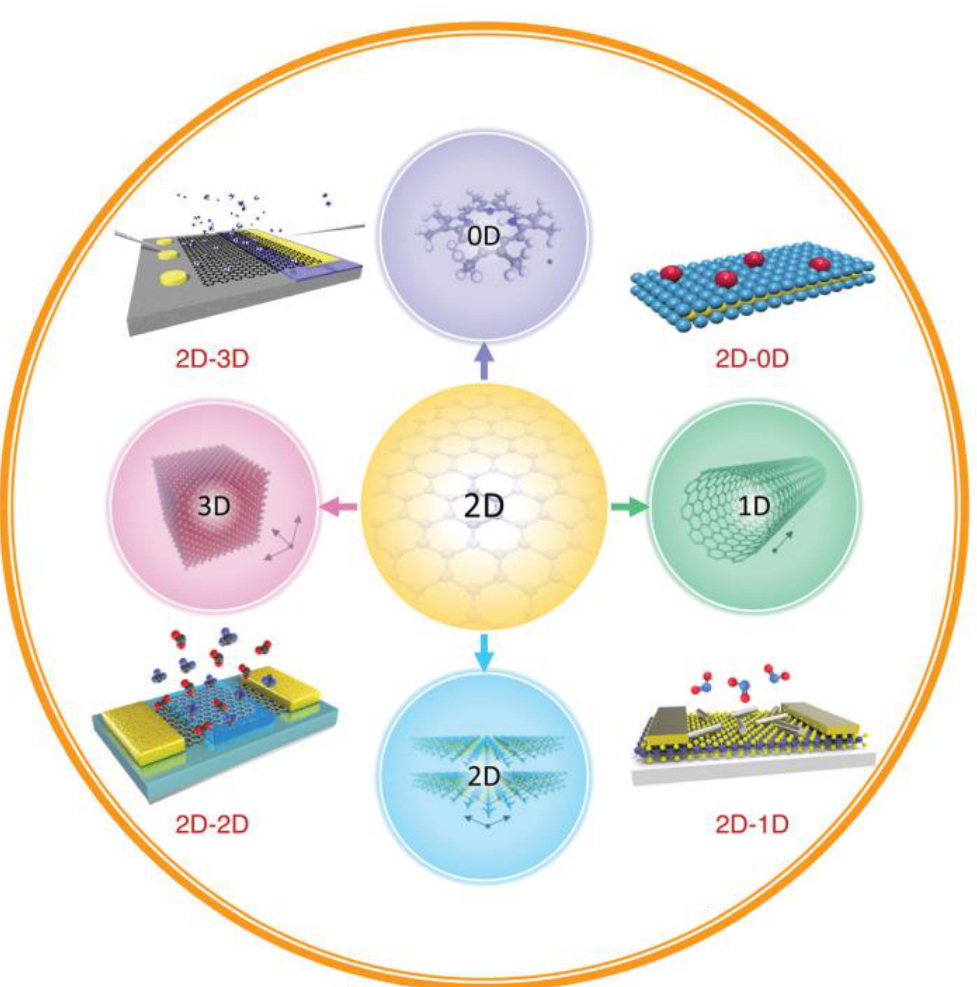
Figure 3. Schematic overview of 2-D nanostructured materials and different types of heterostructures with 0-D, 1-D, 2D, and 3-D materials used for gas-sensing applications. Reproduced with permission from [164].